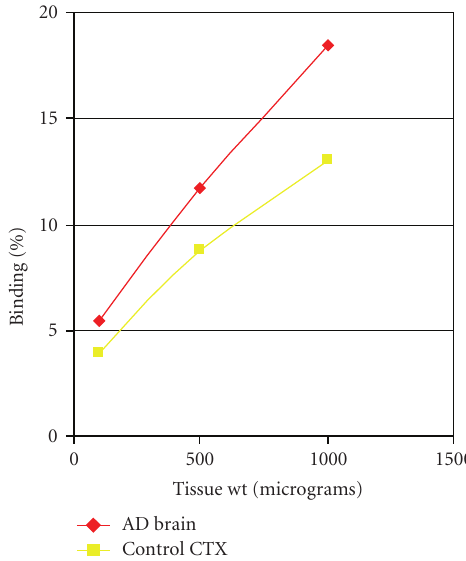
Figure 1: In vitro binding of 125 I-CQ to brain homogenates.